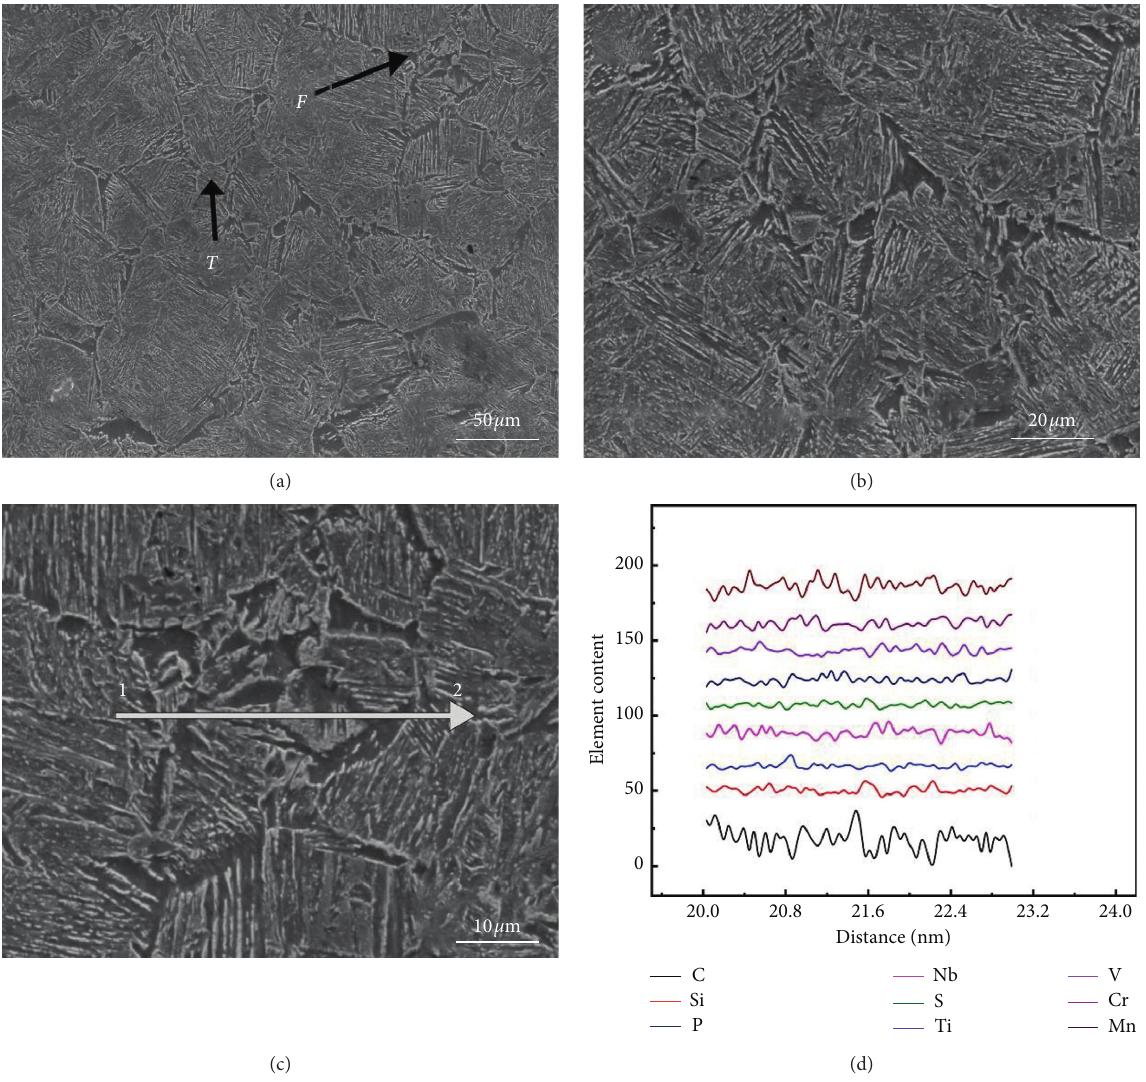
Figure 5: DCT at − 60 ° C and tempering at 350 ° C. (a) Image of SEM, (b) image of OM, (c) line scanning position, and (d) fluctuating of element by line scanning.